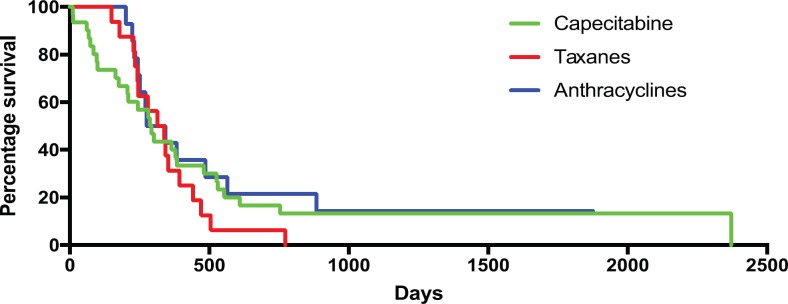
Kaplan-Meier curve of PFS by regimen